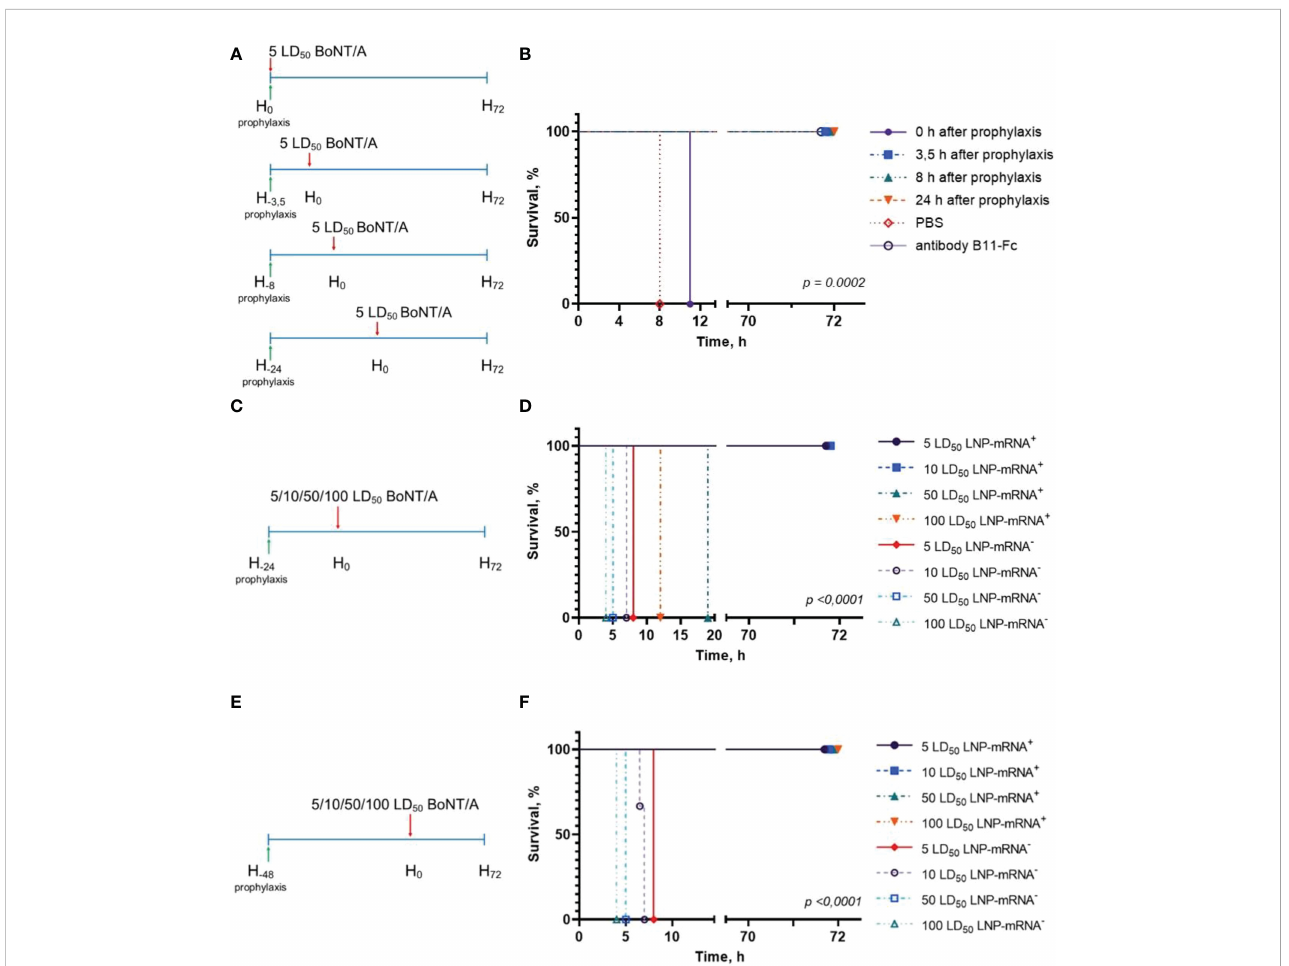
FIGURE 2 Study of mRNA-B11-LNP prophylactic effect. (A) Schedule of passive B11-mRNA-LNP immunization before BoNT/A challenge. A total of three mice per group were challenged and experiment was performed twice. Mice received a single intramuscular (i.m.) injection of 10 m g of B11-mRNA-LNP or recombinant B11-Fc antibody 0, 3.5, 8 or 24 h before 5 LD 50 intraperitoneally injected BoNT/A challenge. Body weight, clinical score and survival were monitored for up to 72 h; (B) Survival curve of mice that were treated according to the schedule in (A) . (C, E) Schedules of passive B11-mRNA-LNP immunization (10 m g of B11-mRNA-LNP per mouse) before challenge by different BoNT/A doses (5, 10, 50 and 100 LD 50 ). A total of three mice per group were challenged and experiment was performed twice. Body weight, clinical score and survival were monitored for up to 72 h; (D, F) Survival curves